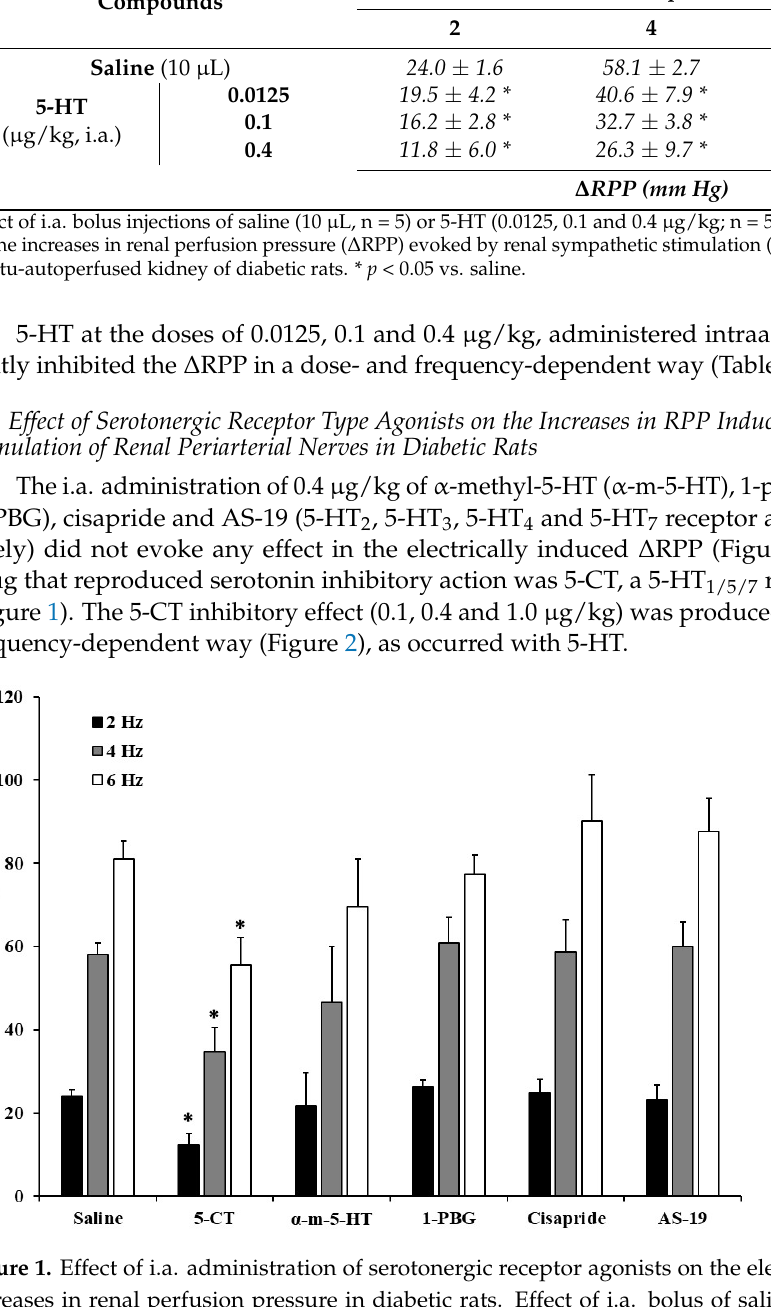
Table 1. Effect of saline and 5-HT on the increases in renal perfusion pressure induced by renal sympathetic stimulation in diabetic rats. Compounds